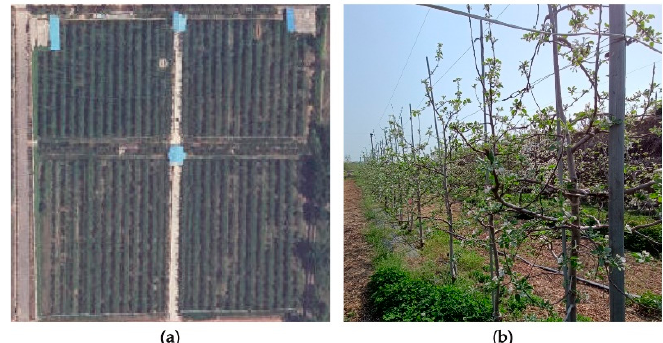
Figure 2. Data collection environment. ( a ) Data collection locations; ( b ) Modern orchards.